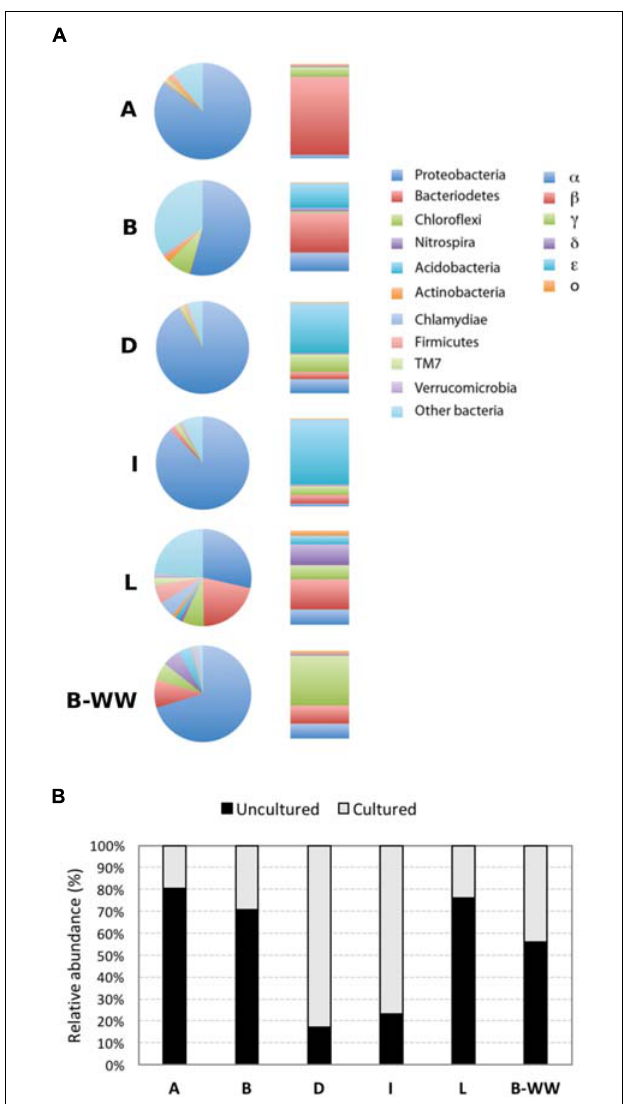
FIGURE 1 | Microbial communities in groundwaters sampled from four drinking water public supplies (A, B, D, and I), one monitoring well (L) and one biofilter unit (B-WW), analyzed by 16S rRNA gene amplicon sequencing. Colored pie charts and bar graphs (A) show the percentage at the phylum level and the percentage of the different classes within the Proteobacteria , respectively. Gray-scale bars (B) represent the percentage of sequences of uncultured vs. cultured species retrieved in the water samples.